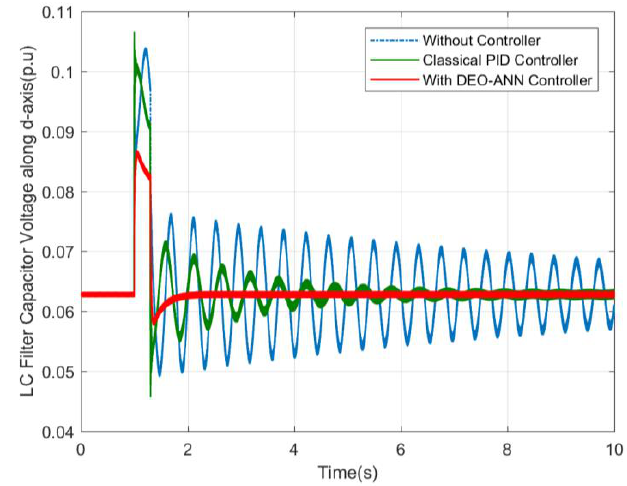
Figure 22. LC filter capacitor voltage along the d-axis.